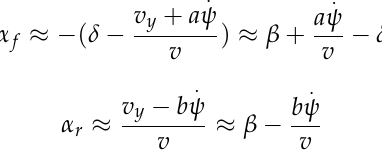
F and F are proportional to the tire slip angle for small an- f r